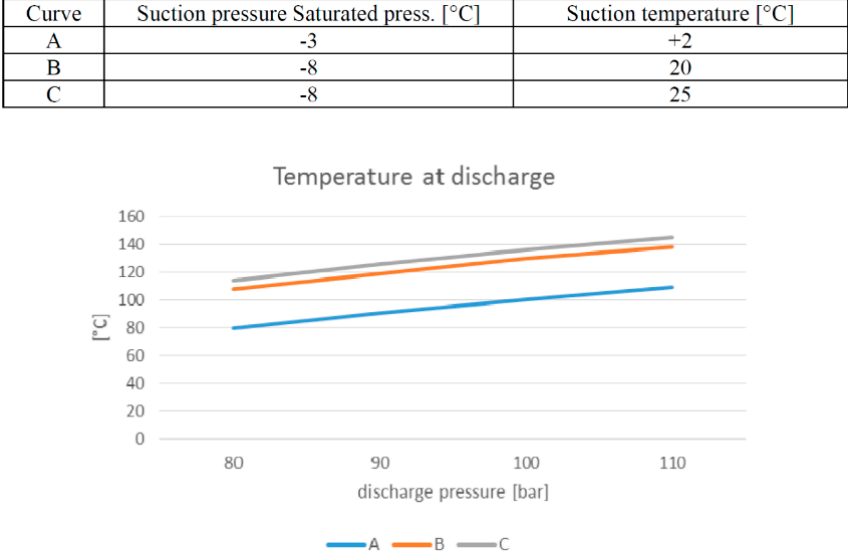
Figure 12. Effect of the heat rejection pressure on the compressor discharge temperature for the 3 investigated scenarios